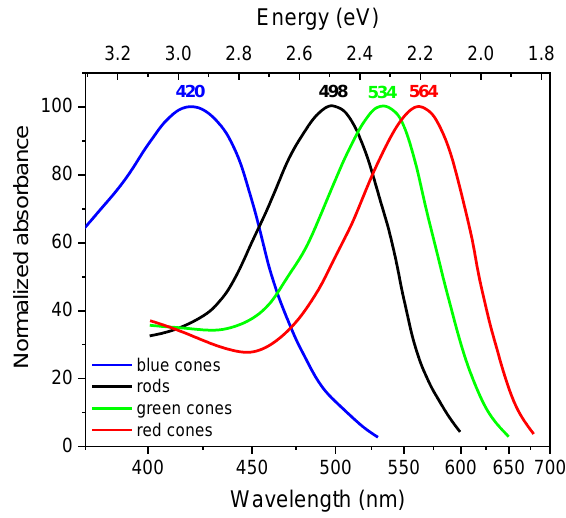
Figure 1. The absorbance spectra of the four classes of human photoreceptors, as follows: rods (R), blue-sensitive cones (S), green-sensitive cones (M), and red-sensitive cones (L). Graphical image made by the authors using data from [31].